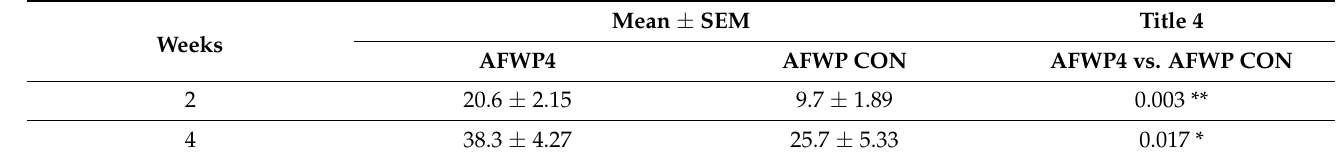
Table 3. Skin moisture content improvement rate (%).